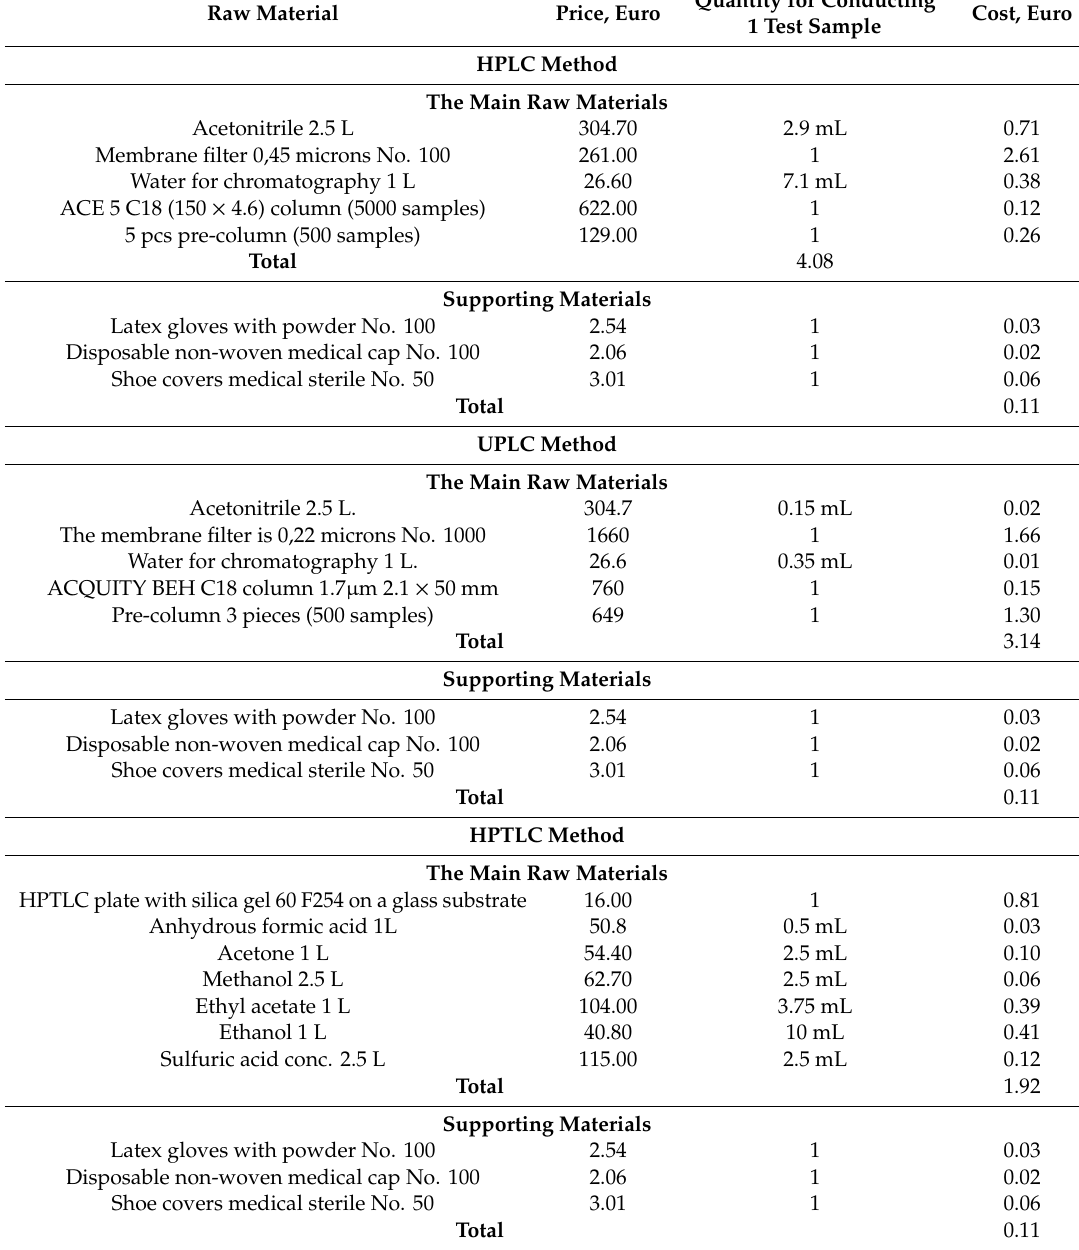
Table 8. Cost expenses under “basic raw materials and materials” and “supporting materials”. Calculation unit—1 sample